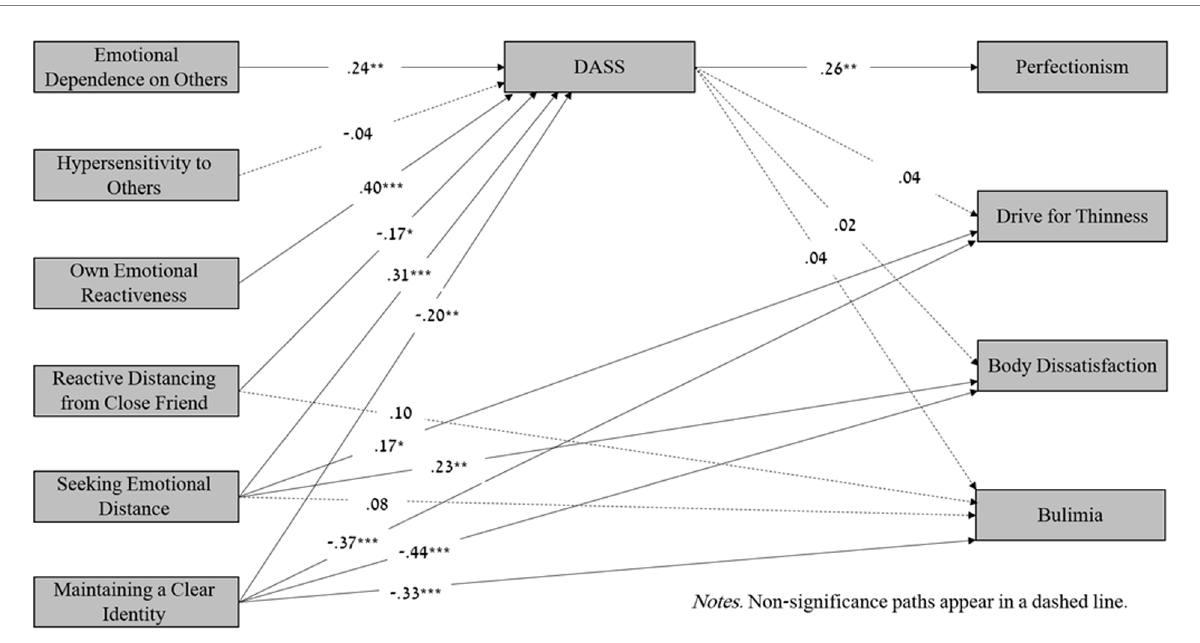
FIGURE 1 Mediation model: The associations between differentiation of self and risk of eating disorders mediated by depression, anxiety and stress (DASS) among females. Non-Significance paths appear in a dashed line.